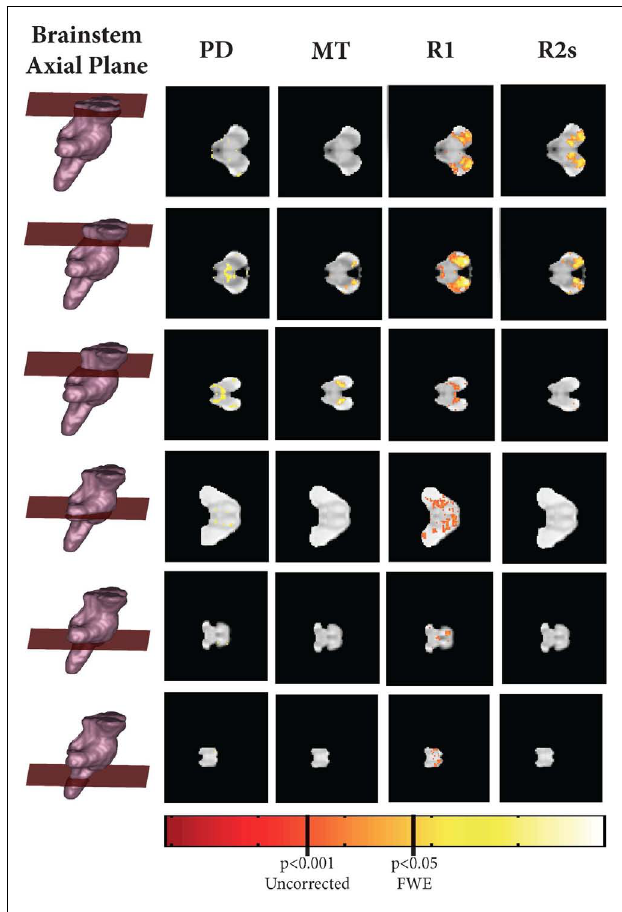
FIGURE 6 |Axial, coronal, and sagittal slice-wise images showing positive correlates with age (R2s, MT,A, R1) projected onto group-average MT map .